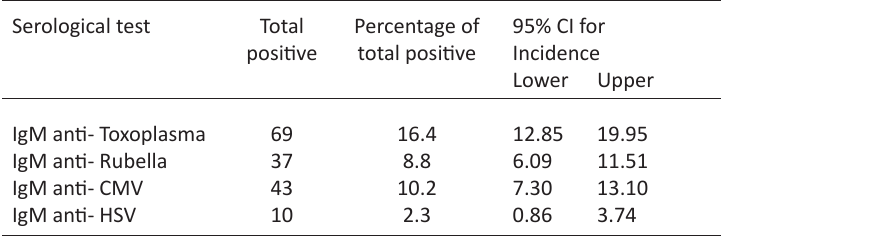
Table 2. Overall sero-positivity of Toxoplasma, Rubella, HSV and CMV Serological